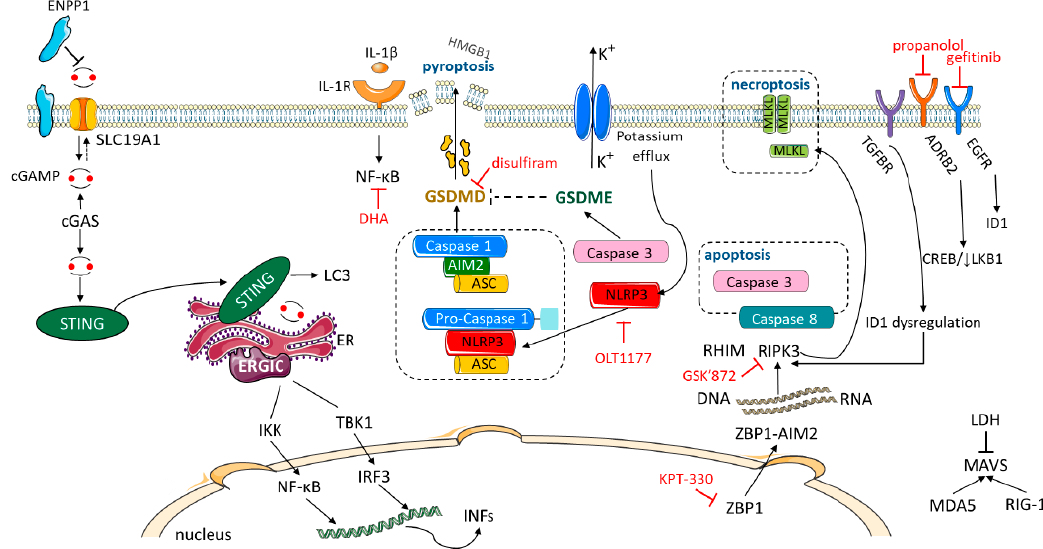
Figure 3. Necroptosis, pyroptosis and cGAS signaling pathways. Necroptosis is a form of programmed necrosis with sequential activation of the receptor-interacting protein kinase 1